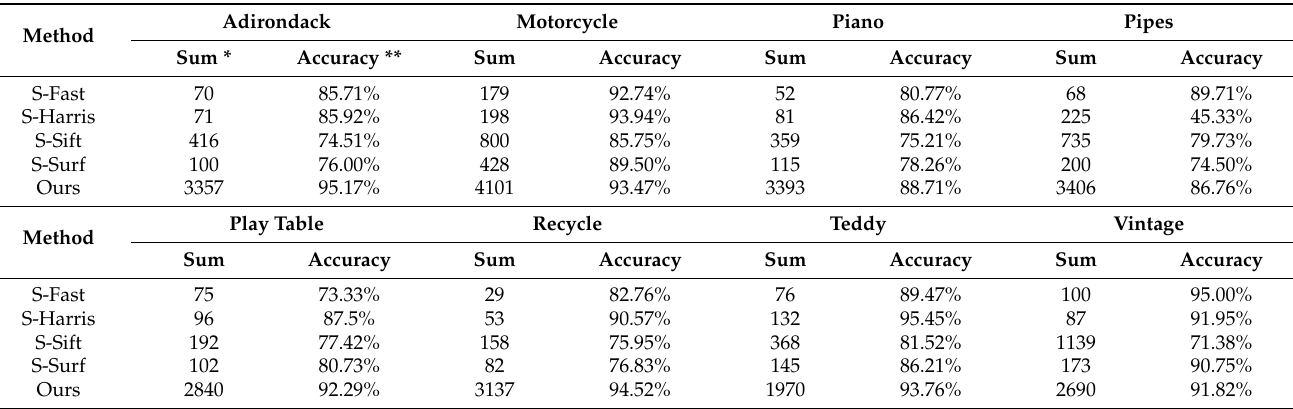
Table 1. Stereo matching